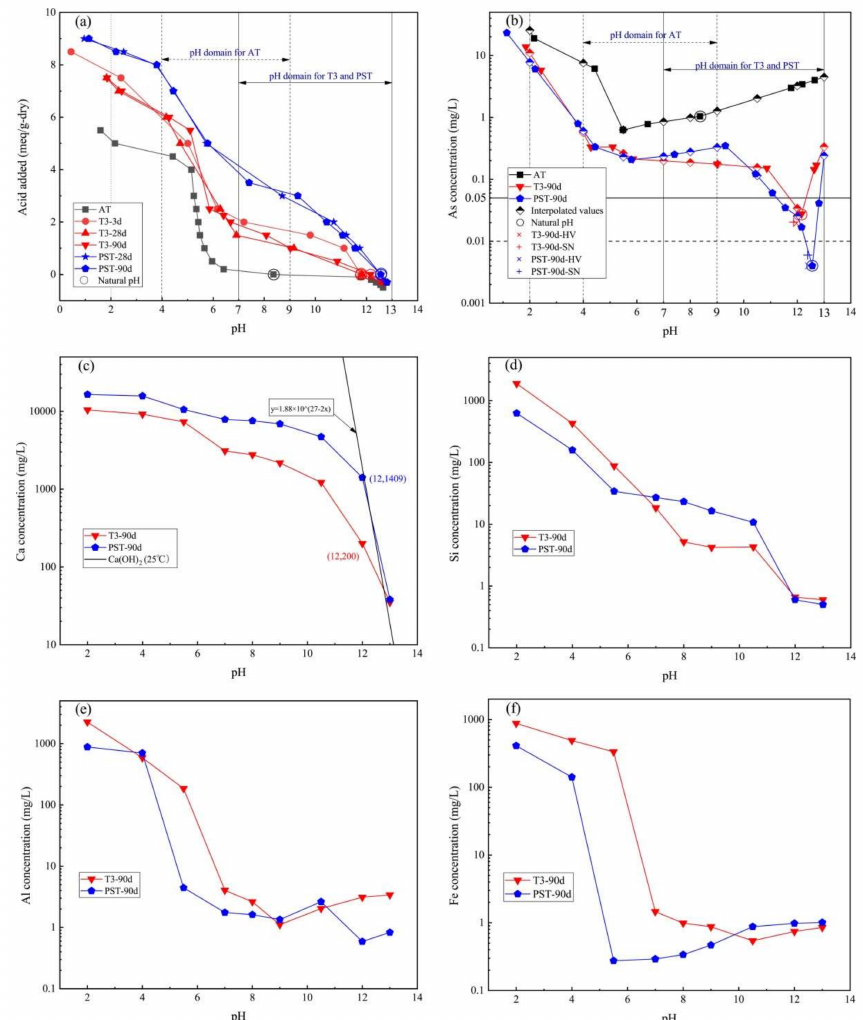
Figure 3. Method 1313 results for ( a ) acid/base neutralization capacity; ( b ) As concentrations; ( c ) Ca concentrations; ( d ) Fe concentrations; ( e ) Al concentrations; ( f ) Si concentrations as a function of leachate pH for T-3-90d and